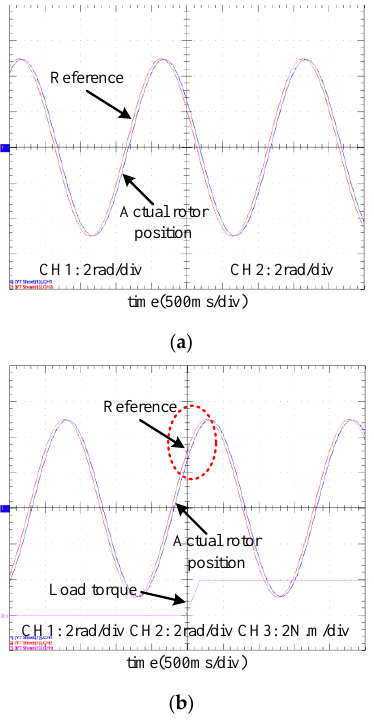
( b ) Figure 14. Rotor position and reference experimental results of the NMPSC with the proposed